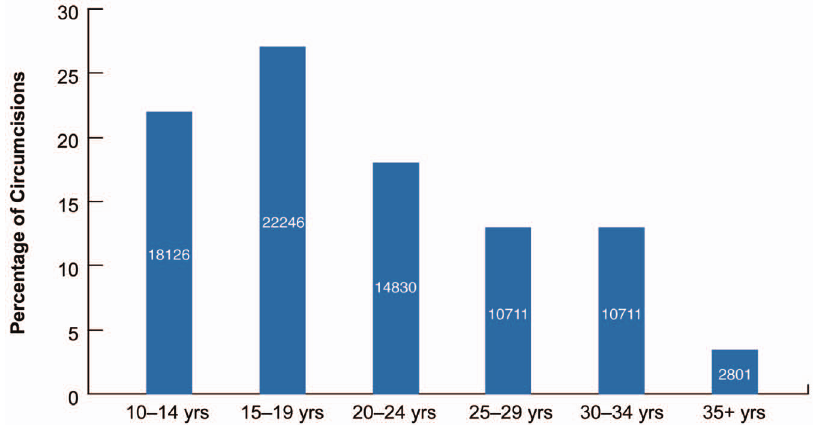
Figure 4. Percentage age distribution of VMMC clients in Zimbabwe, by 2009–2012.